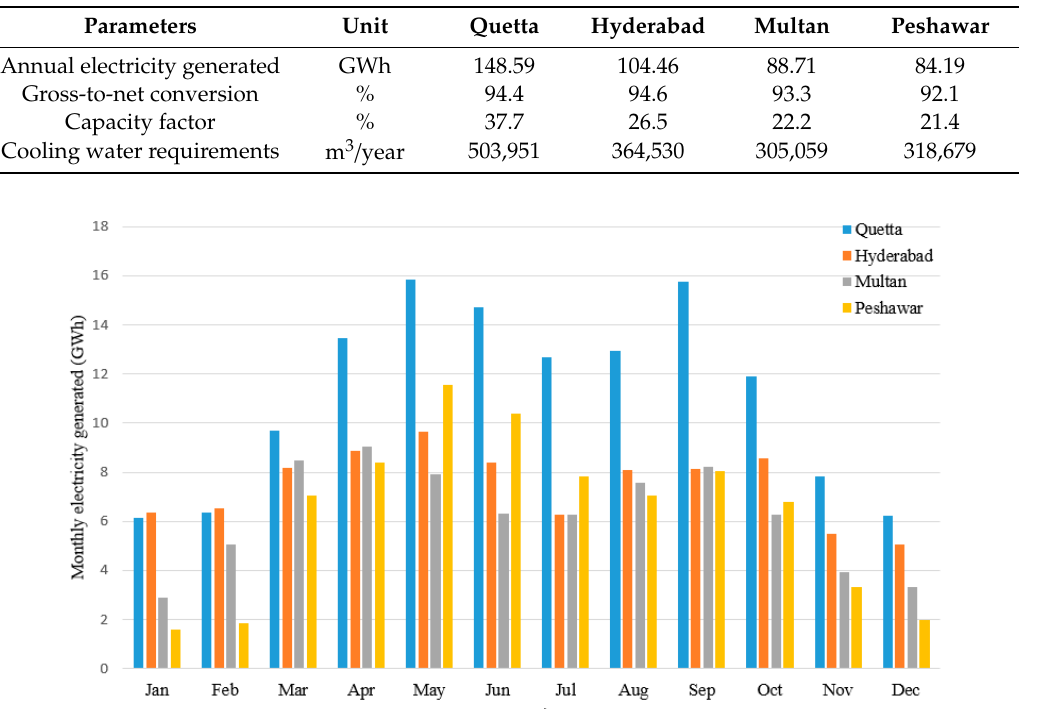
Table 5. Performance parameters of the 50 MWe PT plant with evaporative cooling.